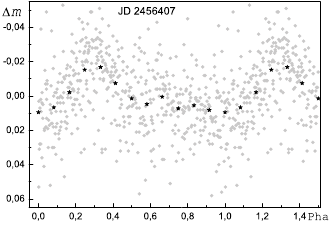
Figure 10: Ordinary superhumps on days 21-22